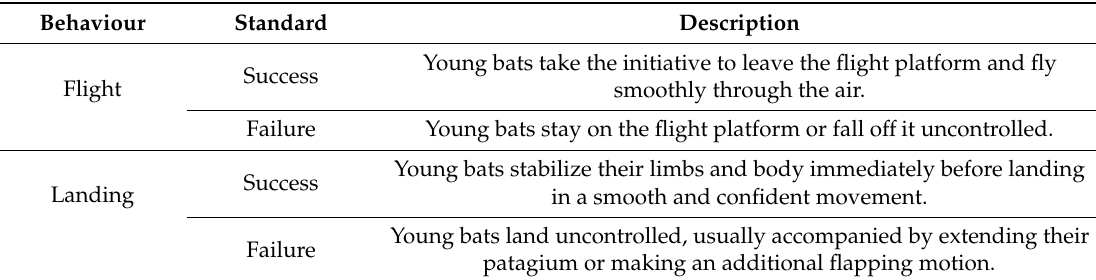
Figure 3. Flight capability determination process. Table 1. Judgement criteria for the flight conditions of young bats [40] .